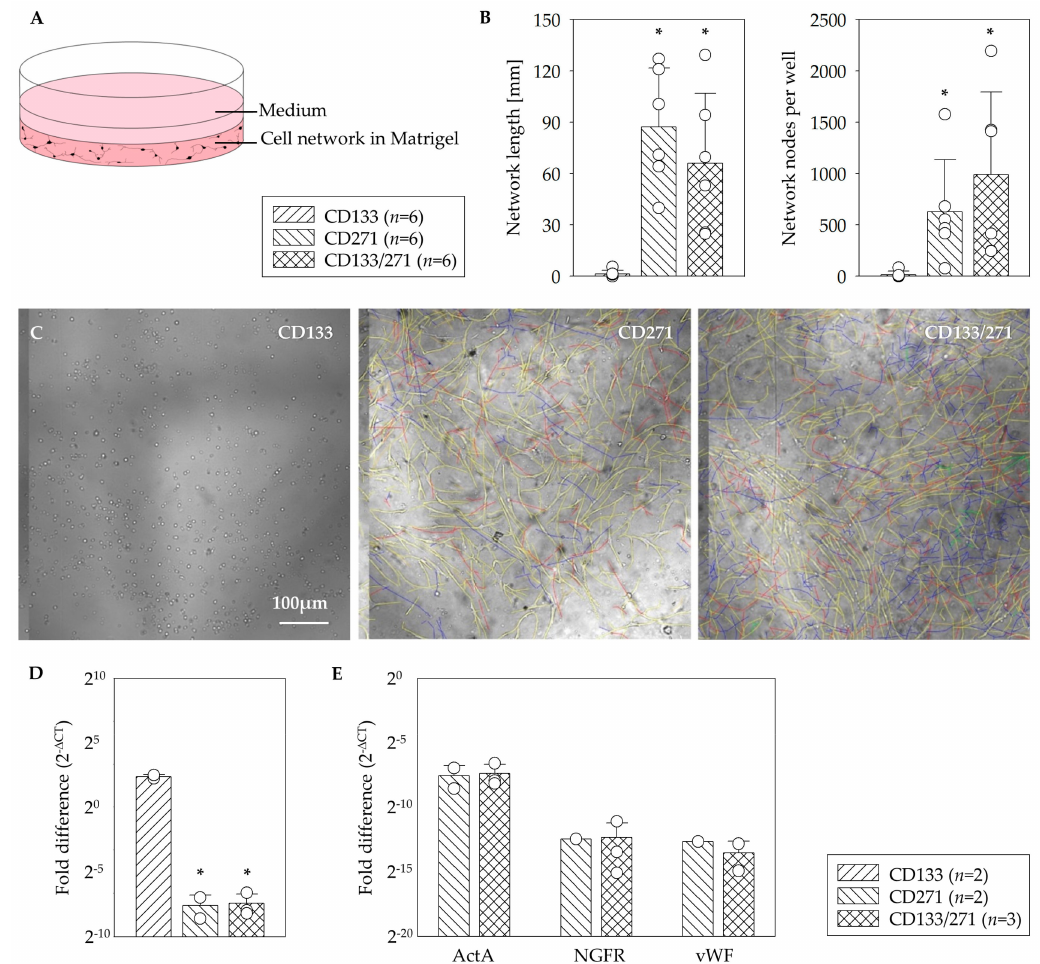
Figure 2. In vitro angiogenesis assay. Schematic illustration of the network formation assay within the Matrigel for testing of the angiogenesis potential ( A ). In contrast to CD133 + cells, a significant formation of network length and highest number of nodal points in the network of CD271 + cells as well as CD133 + / CD271 + cell co-culture were observed ( B ). Representative phase contrast z-stack images of the mono- and co-culture assays ( C ). CD133 + cell culture in Matrigel led to a 10-fold higher level of ActA gene in comparison to CD133 + / 271 + cell co-culture ( D ). No di ff erences were observed between CD271 + and CD133 + / 271 + cell culture assays for ActA , NGFR, and vWF gene expression ( E ). Mean ± SD; * p ≤ 0.015 vs. CD133, Mann–Whitney U